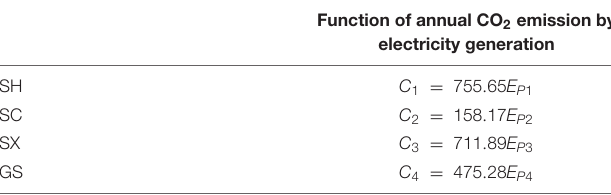
TABLE 4 | Function of annual CO 2 emission by electricity generation.